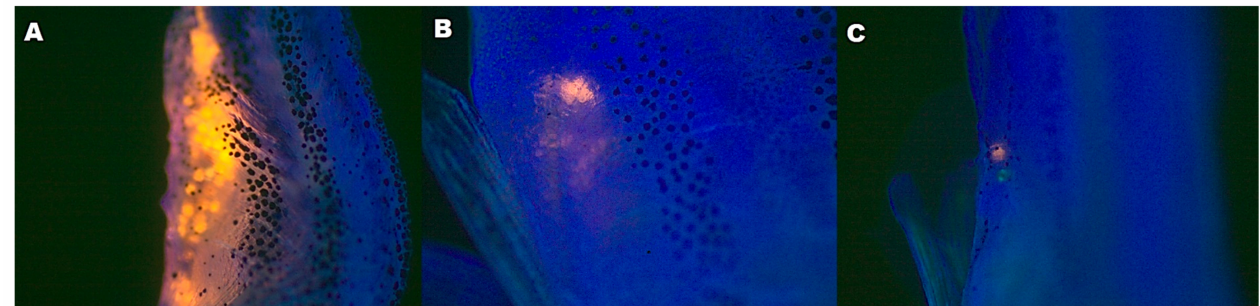
Figure 4. ( A ) Juveniles exposed to 50 mg.L − 1 for 24 h, deposition of particles in the gastrointestinal tract. ( B ) After 7 days of recovery, exposed only in water for depuration. ( C ) After 12 days, few particles are observed in the anal pore. Magnification 40 × .